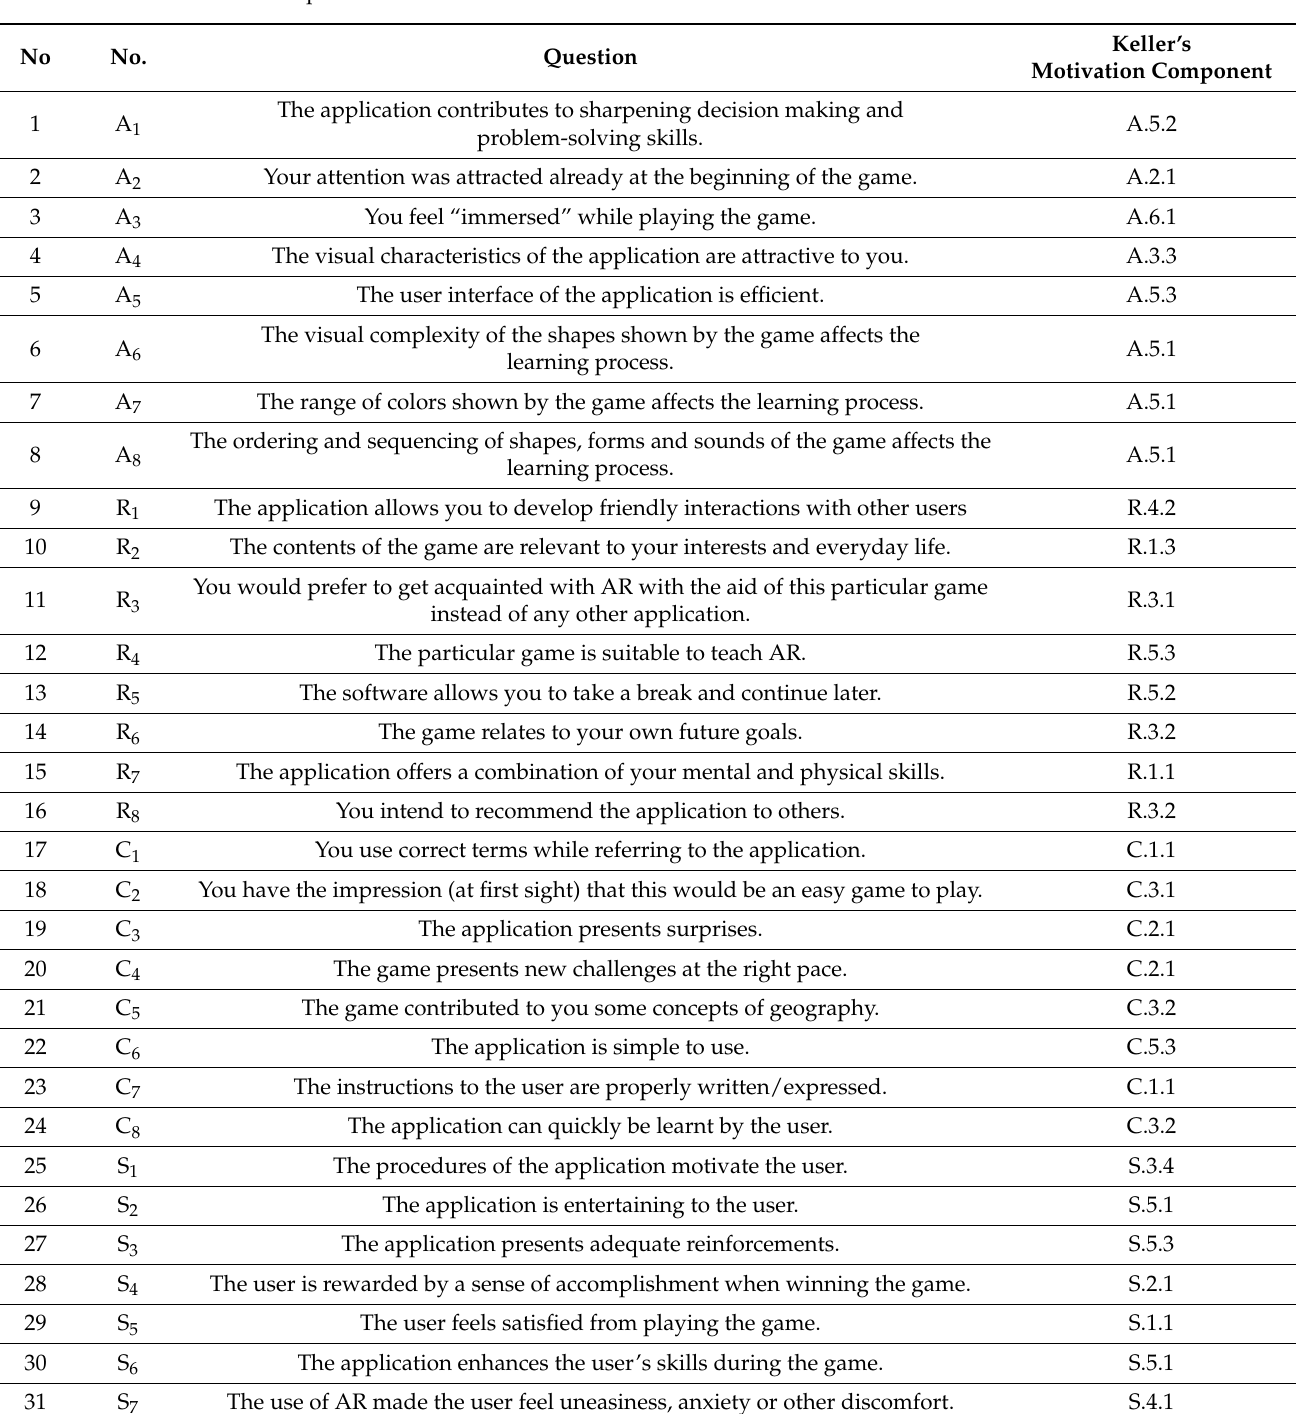
Table 2. Questionnaire to investigate participant motivation with MAR game (Ingress), and correspondence of each question to Keller’s motivation components in the ARCS